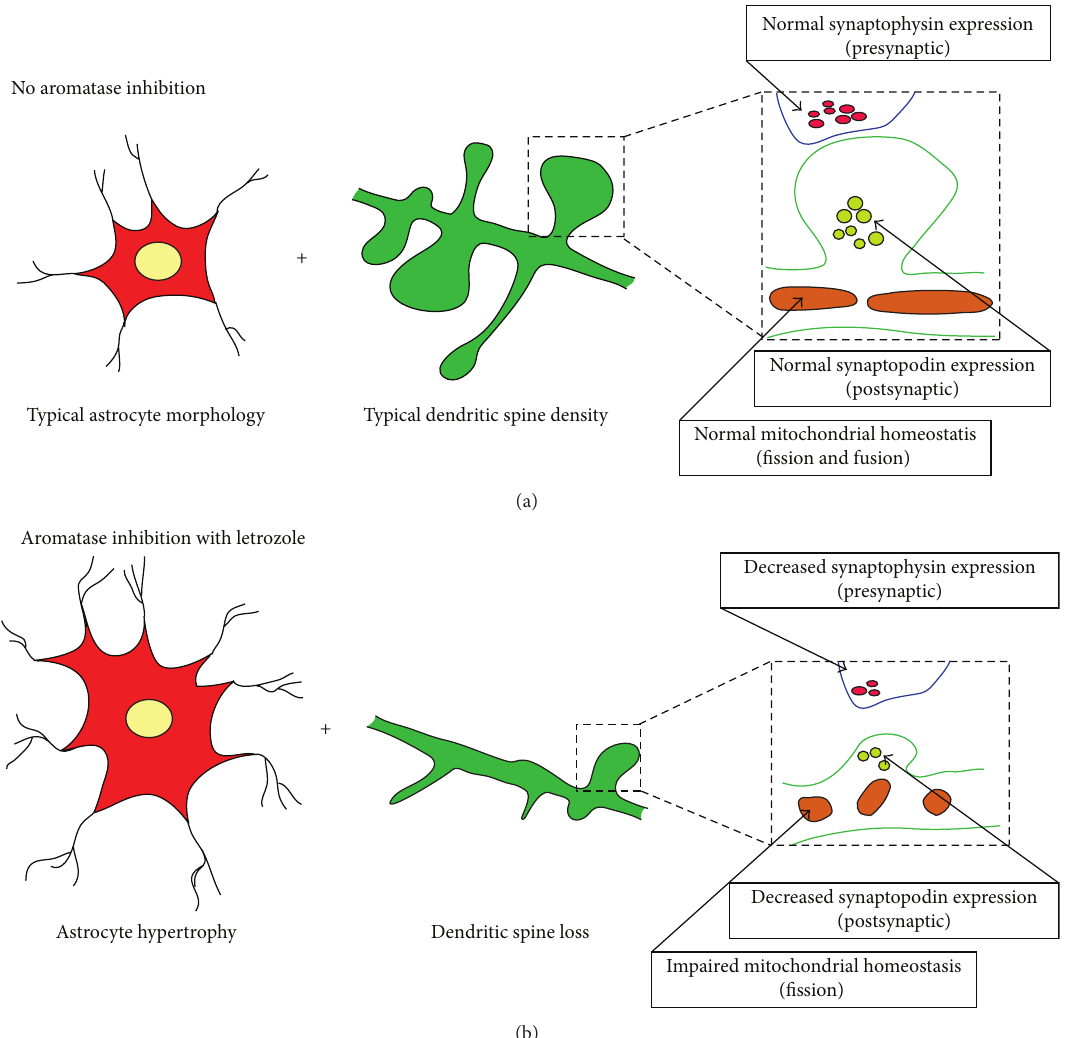
Figure 6: Summarising schematic: aromatase inhibition leads to synaptic and mitochondrial deficits. (a) Aromatase-mediated conversion of testosterone to estrogen in astrocytes serves as a local reservoir of neuroestrogens to promote maintenance of dendritic spines and synaptic mitochondrial integrity. (b) Aromatase inhibition by letrozole leads to spine loss, pre- and postsynaptic protein deficits, and compromised mitochondrial